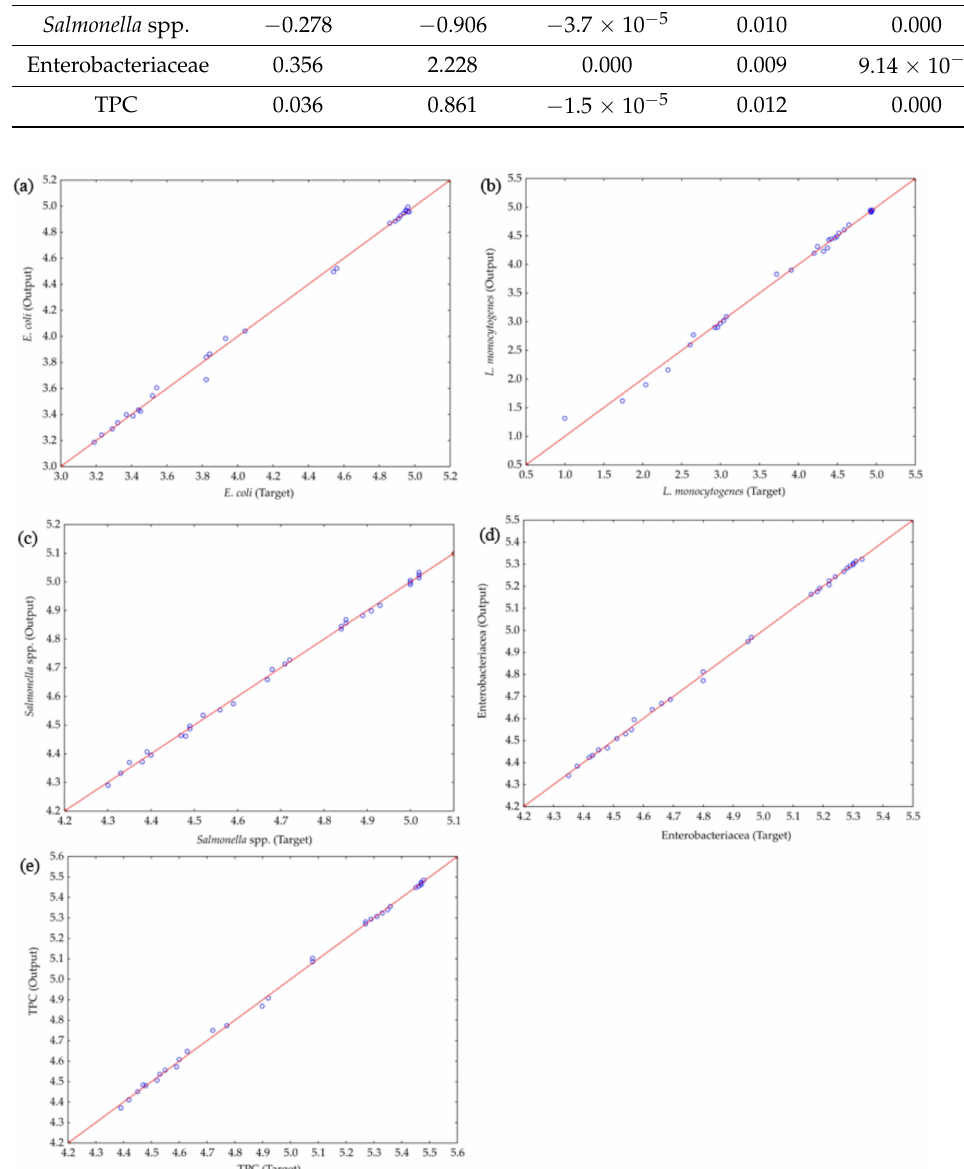
Figure 4. Comparison between experimentally obtained and ANN model–predicted values of ( a ) E. coli , ( b ) L. monocytogenes , ( c ) Salmonella spp., ( d ) Enterobacteriaceae, and ( e )